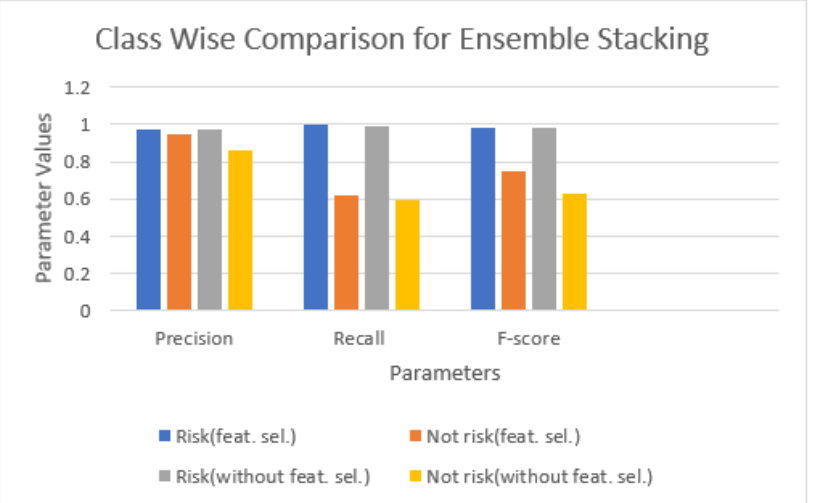
Figure 5. Comparison of performance metrics with or without Feature Selection for Stacking